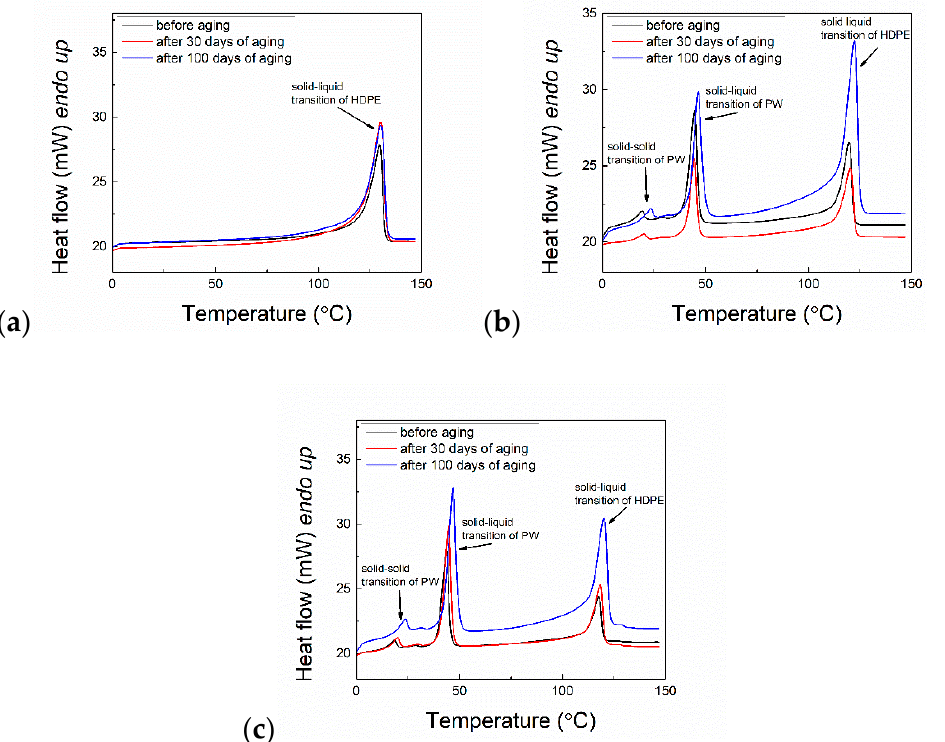
Figure 6. Differential Scanning Calorimetry (DSC) thermographs of ( a ) pure HDPE, ( b ) S 3 and ( c ) S 7 PCMs. Table 1. DSC melting temperatures and enthalpies for the different compositions of PCMs during